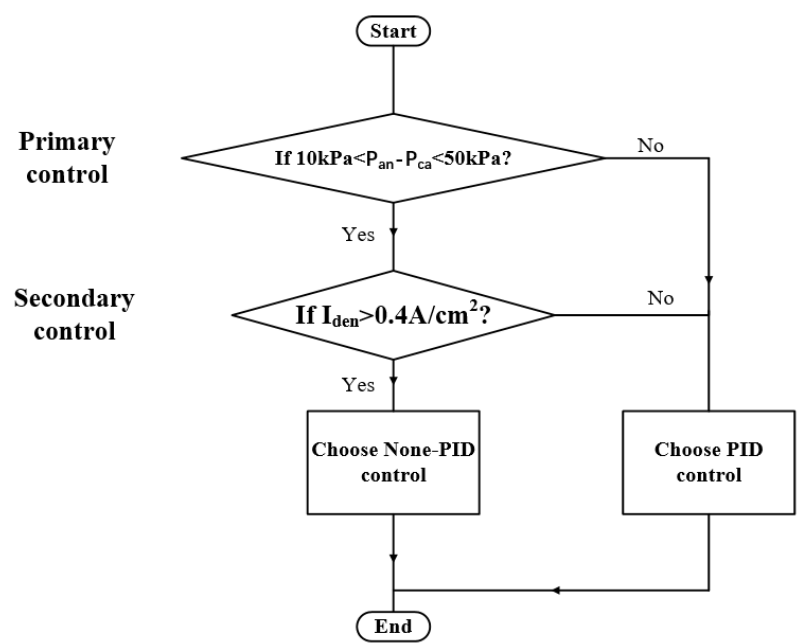
Figure 7. Flow chart of the hierarchical control policies in the two modes.